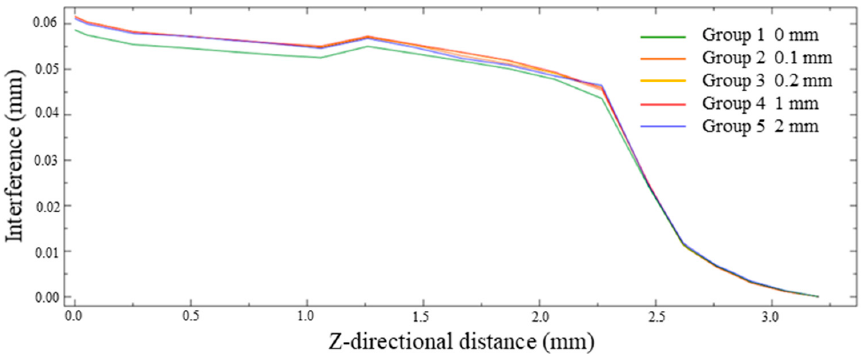
Figure 8. Distribution of rivet interference in joints with different